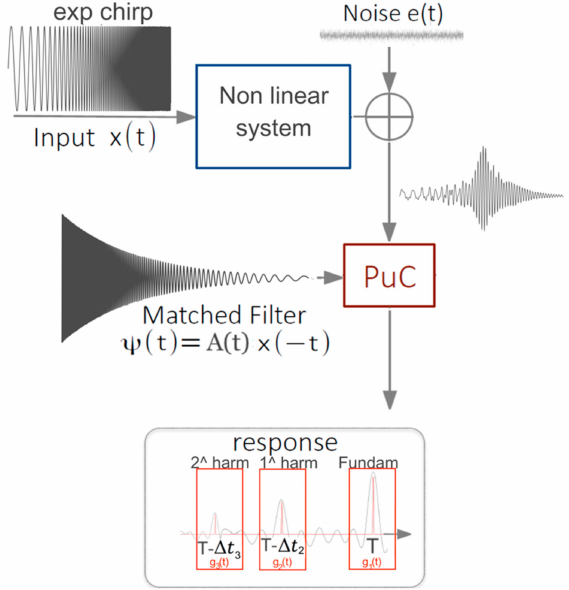
Figure 2. The Pulse Compression (PuC) procedure for identifying the Hammerstein